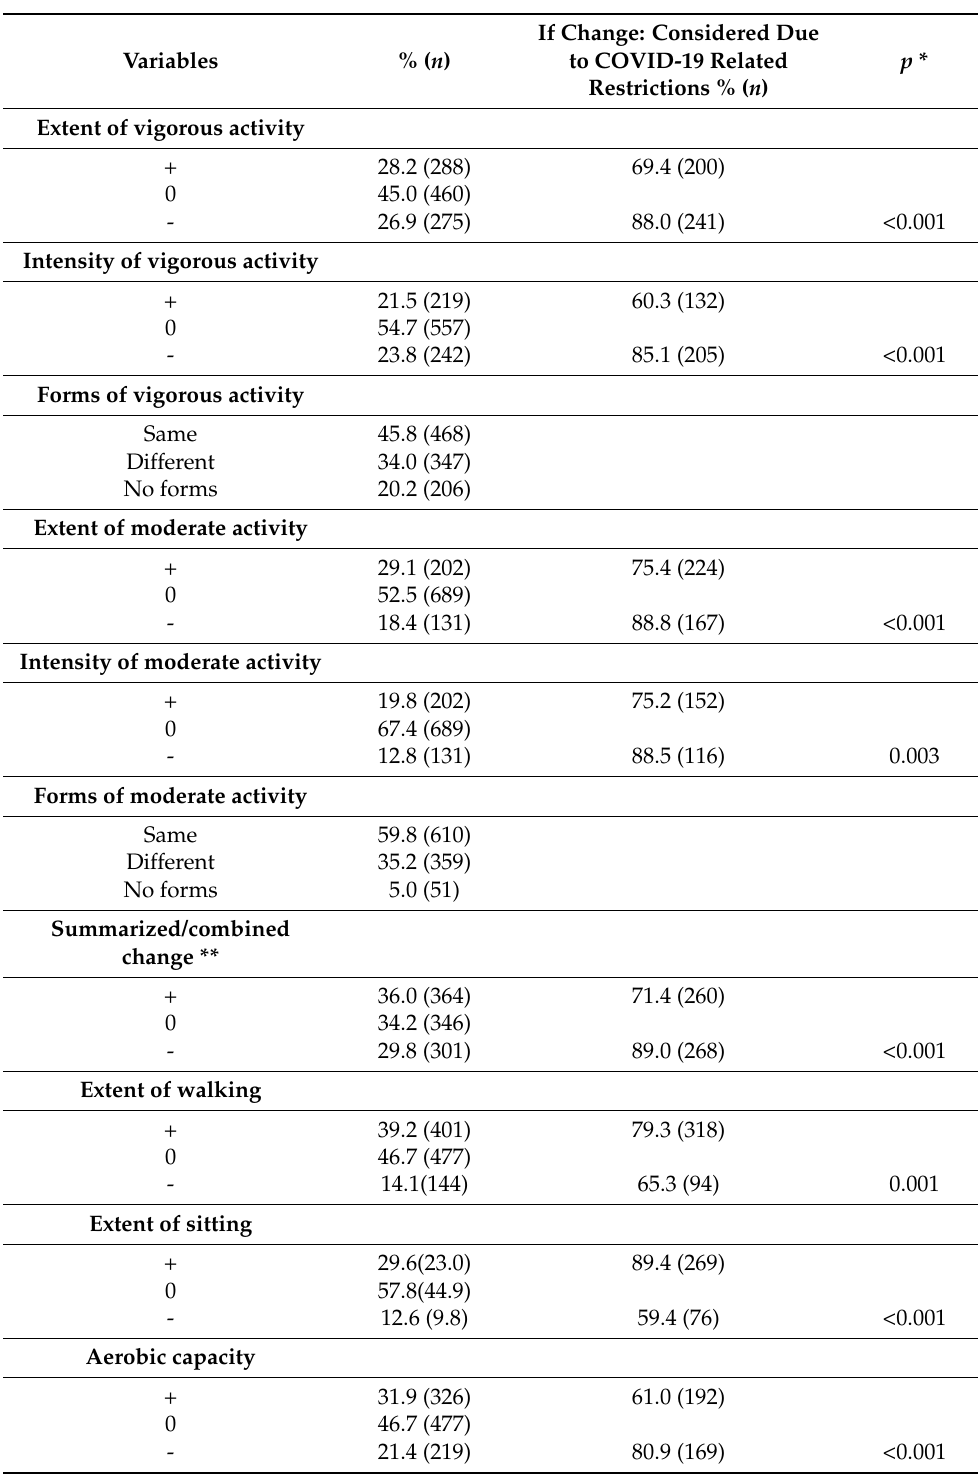
Table 2. Reported change in physical activity behaviors and capacity compared with the same time the previous year, and perceived change due to COVID-19-related